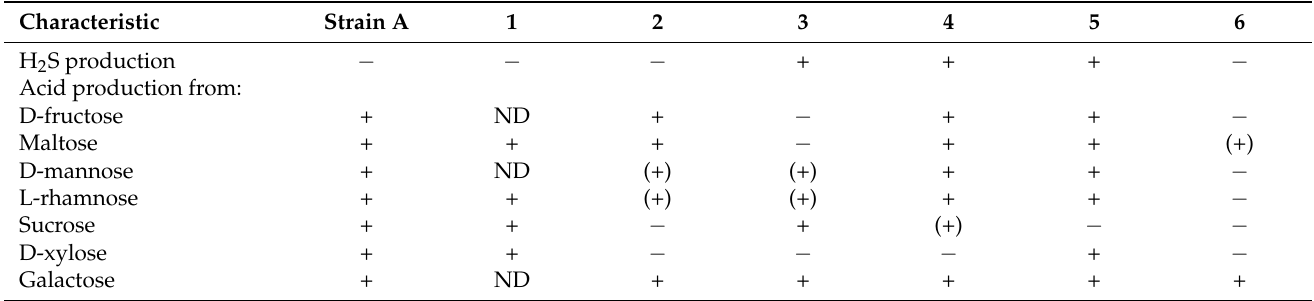
Table 3. Physiological and biochemical characteristics of strain B. Strains: 1, M. barkeri DSM 20145 T